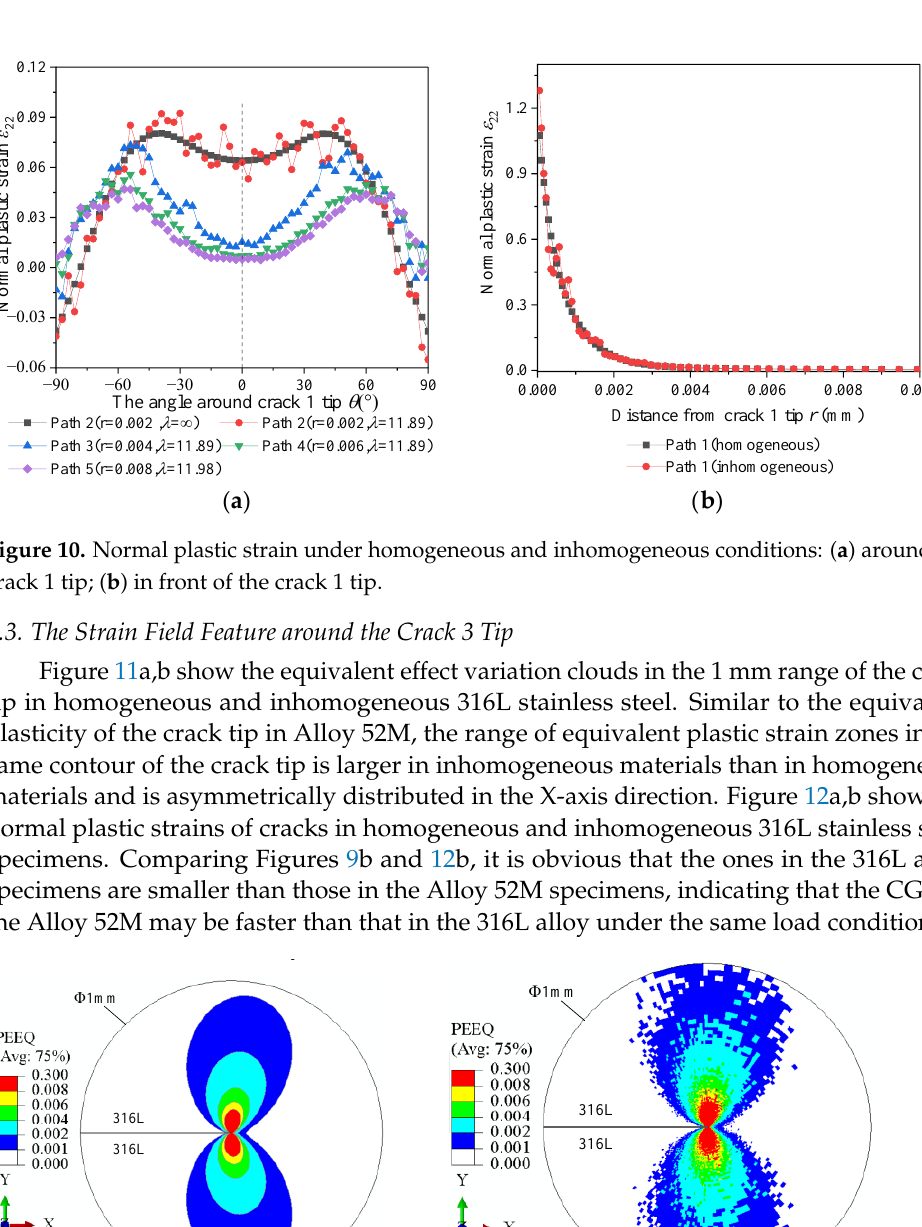
Figure 9. Normal plastic strain at the tip of crack 1: ( a ) homogeneous; ( b ) inhomogeneous.